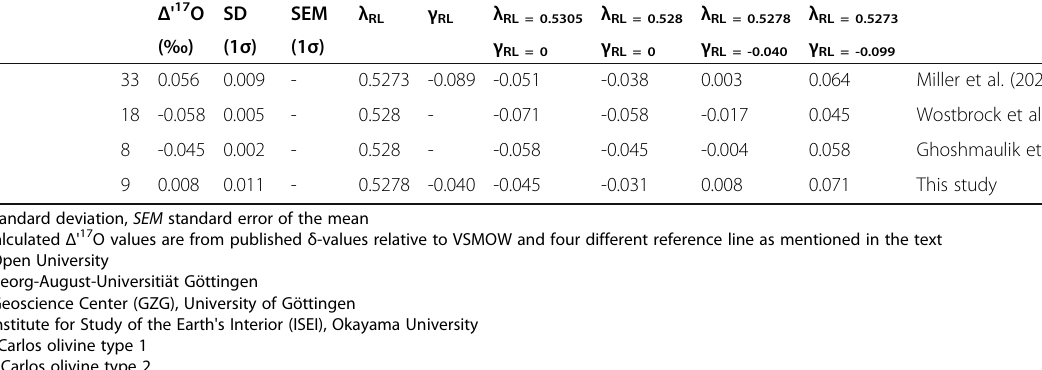
Table 4 Literature data of Δ ' 17 O and recalucalted Δ ' 17 O relative to different assigned reference lines (Continued) Sample n Literature